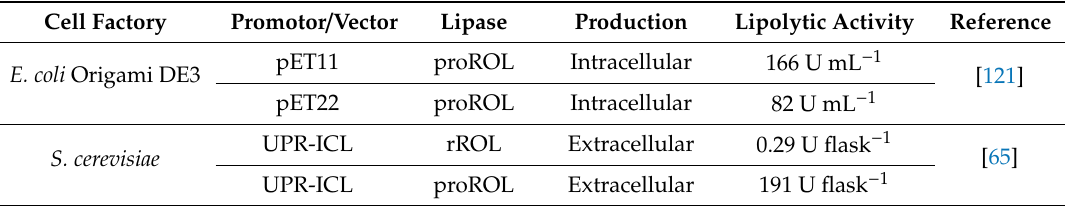
Table 3. Summary of E. coli and S. cerevisiae cell factories expressing Rhizopus oryzae